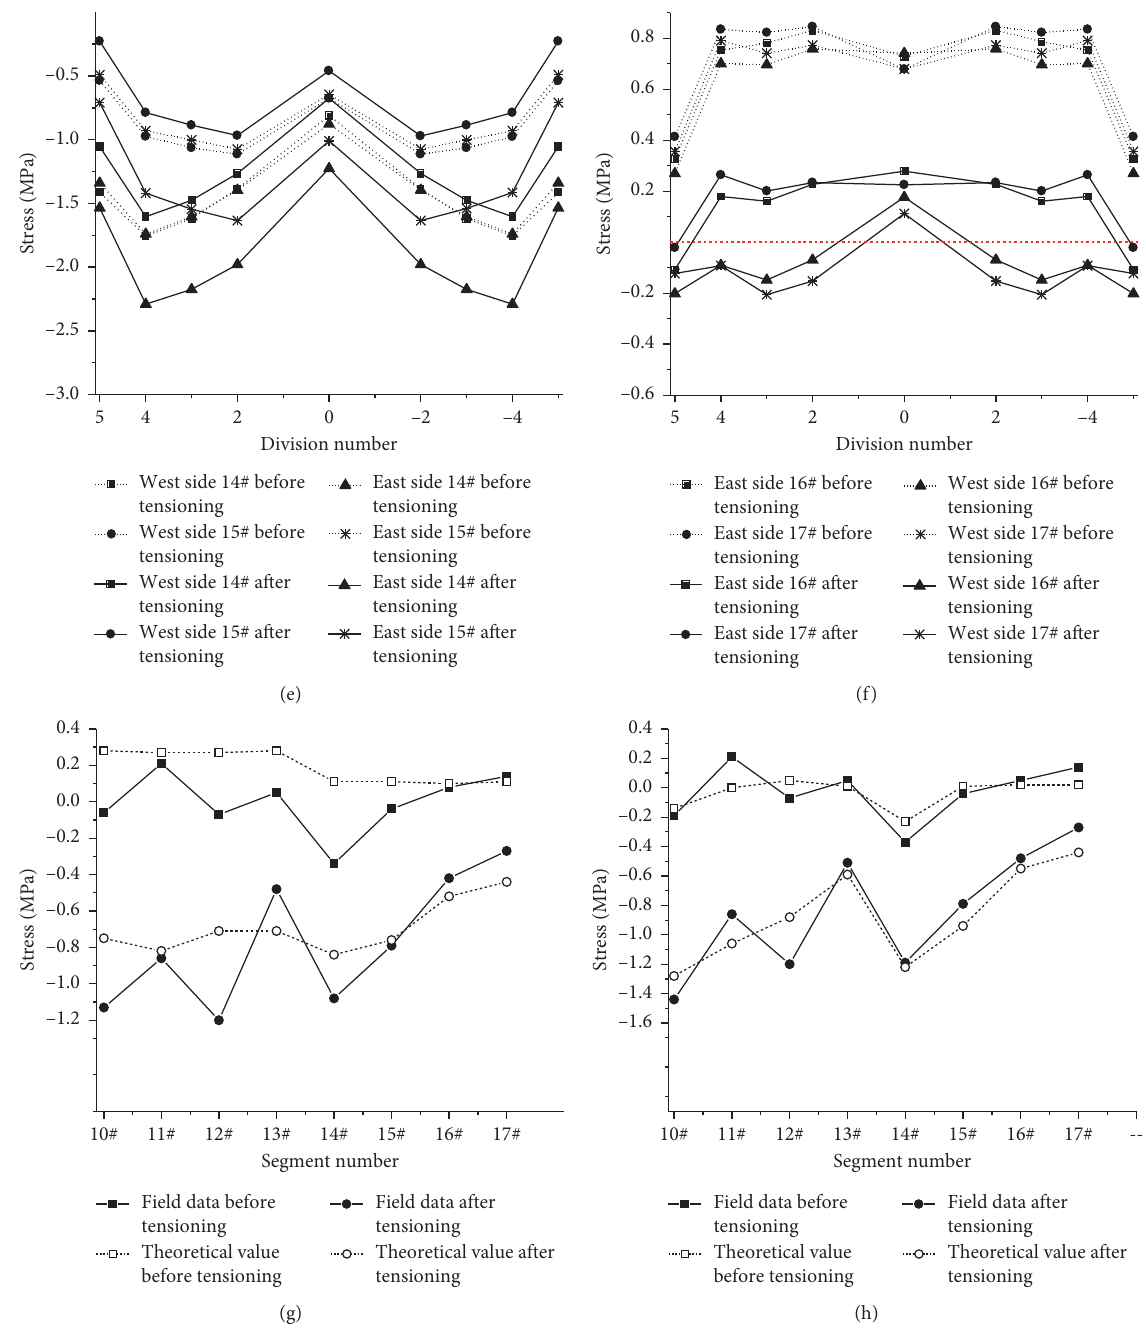
Figure 12: Comparisons of the prestressing patterns and field test of the upper edge tensile stresses. The abscissas from (a) to (f) denoting the numbering of the divided beam cross-sectional areas can refer to Figure 10(a). (a) Upper edge stress distribution of the end cross sections of the no.10 and 11 segments (case 1). (b) Upper edge stress distribution of the end cross sections of the no.12 and 13 segments (case 2). (c) Lower edge stress distribution of the end cross sections of the no. 12 and 13 segments (case 2). (d) Upper edge stress distribution of the end cross sections of the no. 14 and 15 segments (case 3). (e) Lower edge stress distribution of the end cross-sections of the no. 14 and 15 segments (case 3). (f) Upper edge stress distribution of the end cross sections of the no. 16 and 17 segments (case 4). (g) Maximum upper edge tensile stresses (east field data). (h) Maximum upper edge tensile stresses (west field